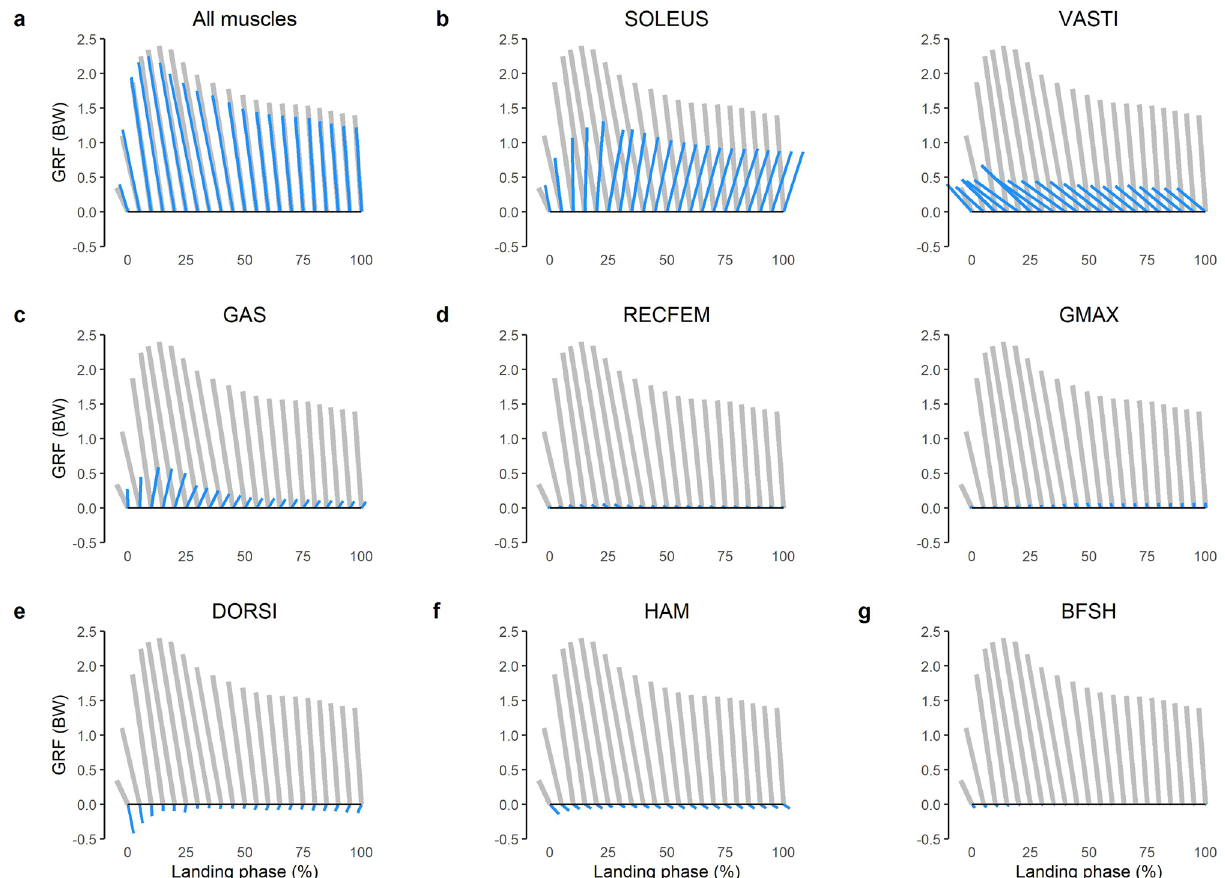
Figure 4. Mean musculotendinous contributions to the bodyweight (BW) normalised ground reaction force (GRF) for the landing phase (initial contact to peak knee flexion) of a single-leg drop landing from a 0.31 m height. Vectors oriented upward and to the right indicate superiorly and anteriorly directed GRFs, respectively. Grey vectors represent the net GRF measured from ground embedded force plate, whilst blue vector indicates muscle contributions as follows: All muscles, sum of all musculotendinous actuators in the model; SOLEUS, soleus; VASTI, vasti (sum of vastus intermedius, lateralis and medialis); GAS, gastrocnemius (sum of lateral and medial gastrocnemius) RECFEM, rectus femoris; GMAX, gluteus maximus; DORSI, ankle dorsiflexors (sum of tibialis anterior, extensor hallucis and digitorum longus); HAM, biarticular hamstrings (sum of biceps